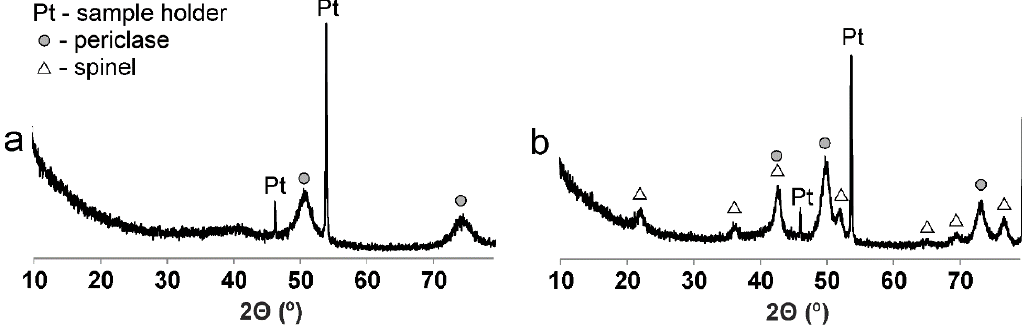
Figure 4. The powder patterns of quintinite decomposition products at ( a ) 500 and ( b ) 1000 °C.